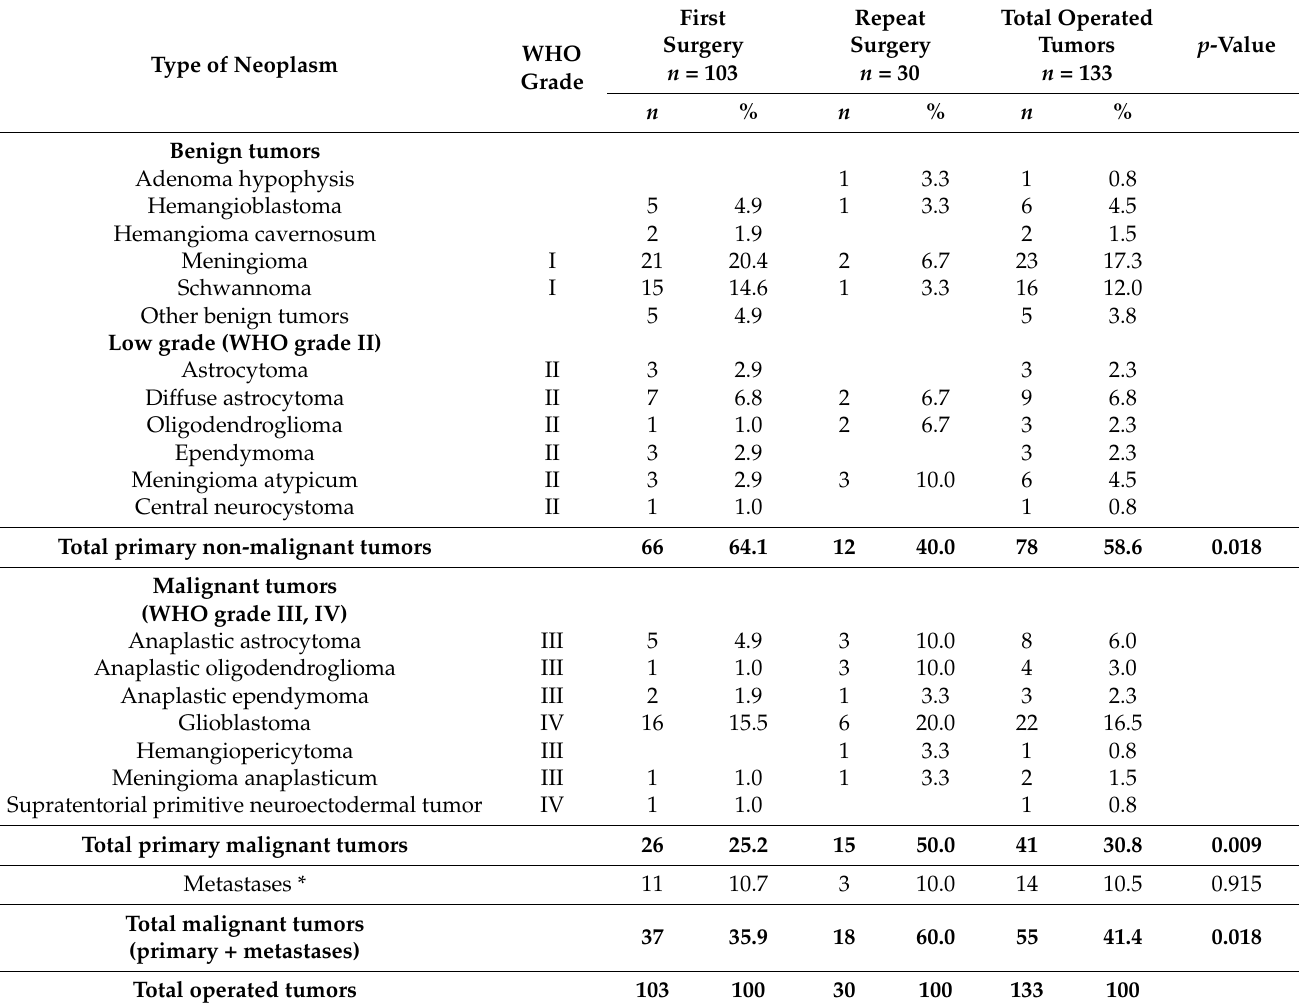
Table 1. Types of neoplasm in patients rehabilitated after first and repeat surgery for brain tumors ( n =